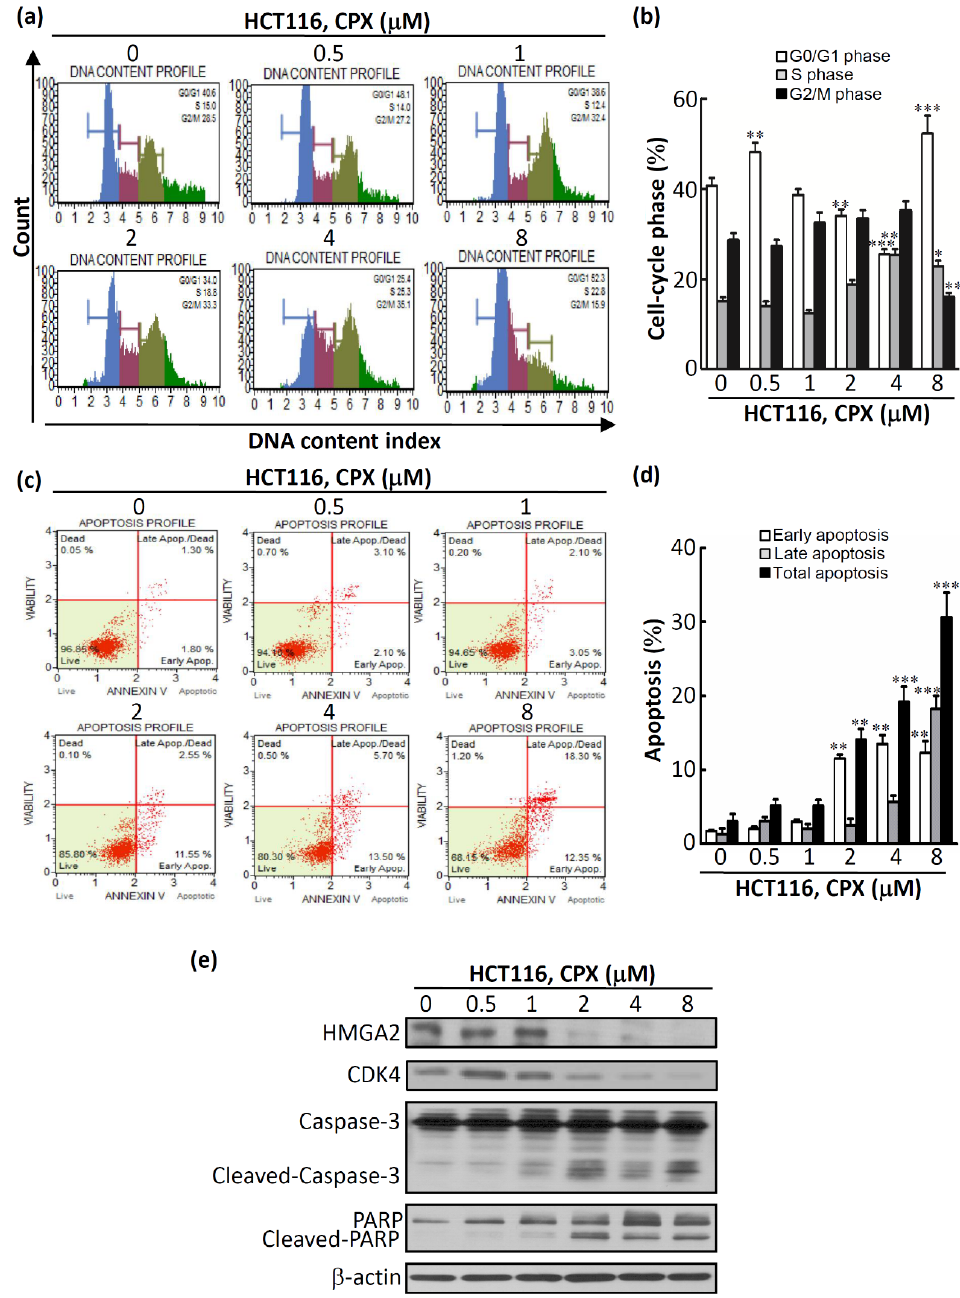
Figure 3. CPX-induced cell cycle arrest and apoptotic death in HCT116 cells. ( a ) HCT116 cells were treated with CPX at the indicated concentrations for 48 h. Cells were subjected to a cell cycle assay using the Muse Cell Analyzer. ( b ) The statistical analysis of cell cycle distribution. ( c ) HCT116 cells were treated with CPX at the indicated concentrations for 48 h. Cells were subjected to an annexin V assay using the Muse Cell Analyzer. The method led to four categories: dead, alive, early apoptosis, and late apoptosis / dead. ( d ) CPX significantly induced total apoptotic cells (black bar) in a dose-dependent manner. ( e ) HCT116 cells were treated with CPX at the indicated concentrations for 48 h, subjected to a western blot analysis, and probed for HMGA2, CDK4, caspase-3, and poly (ADP ribose) polymerase (PARP). β -actin was used as the loading control. * p < 0.05, ** p < 0.01, *** p <